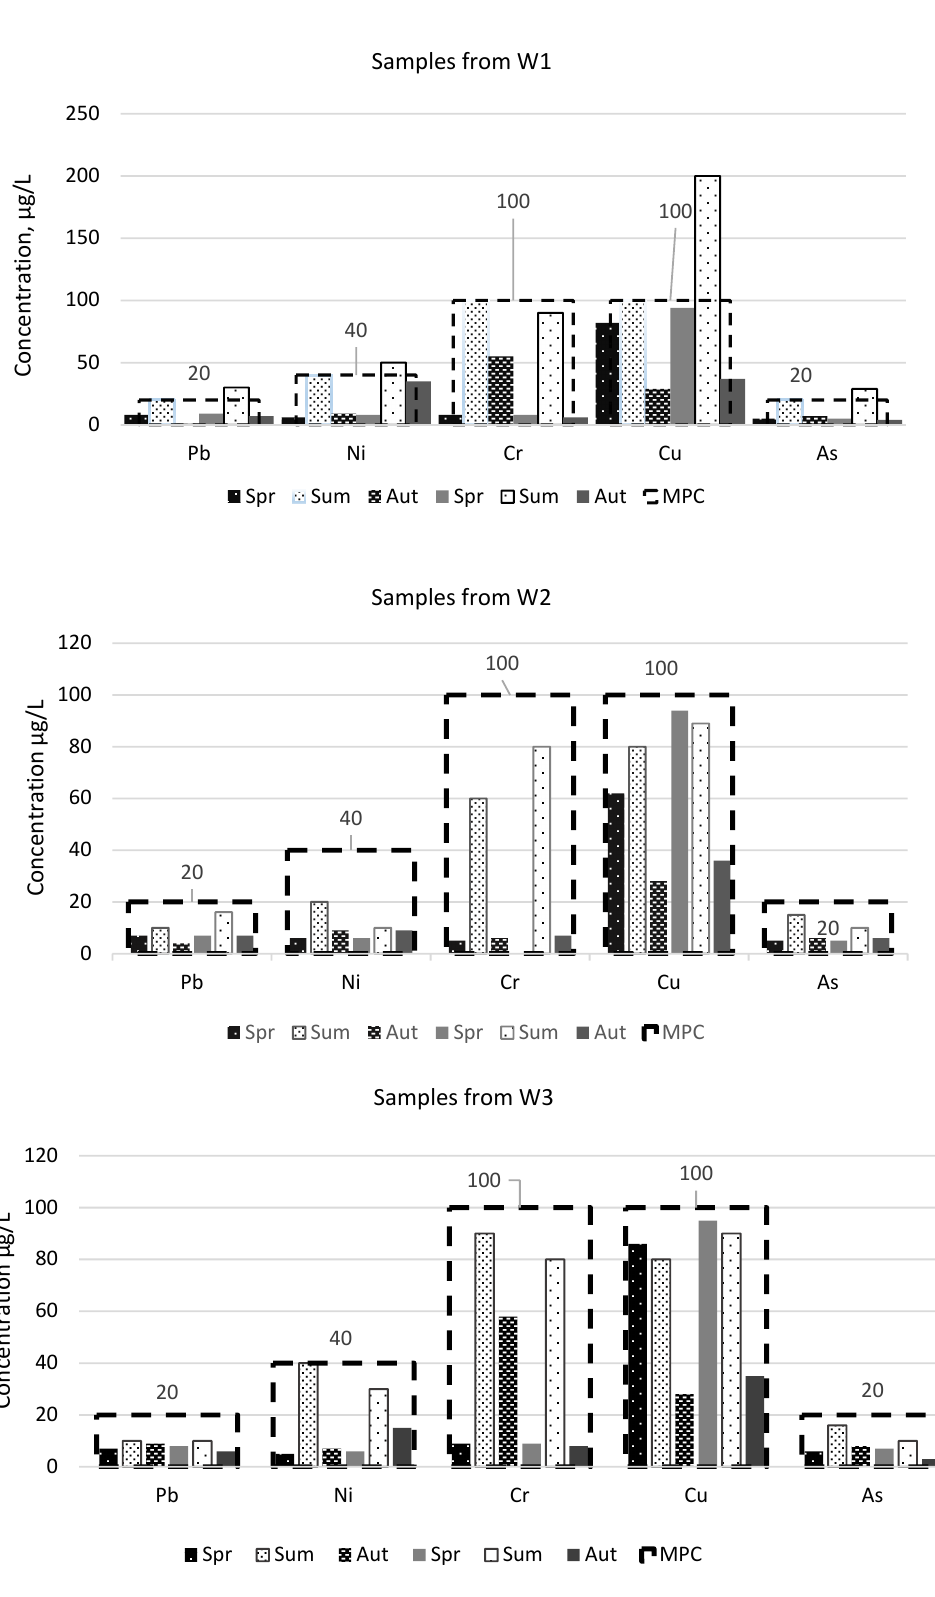
Figure 4. The concentration of heavy metals and metalloid in water of river during research period (Aut—autumn season, Sum—summer season, Spr—spring season, MPC—maximum permissible concentration for disposal treated wastewater, according to Waste Water Regulation of the Government of the Republic of Lithuania.